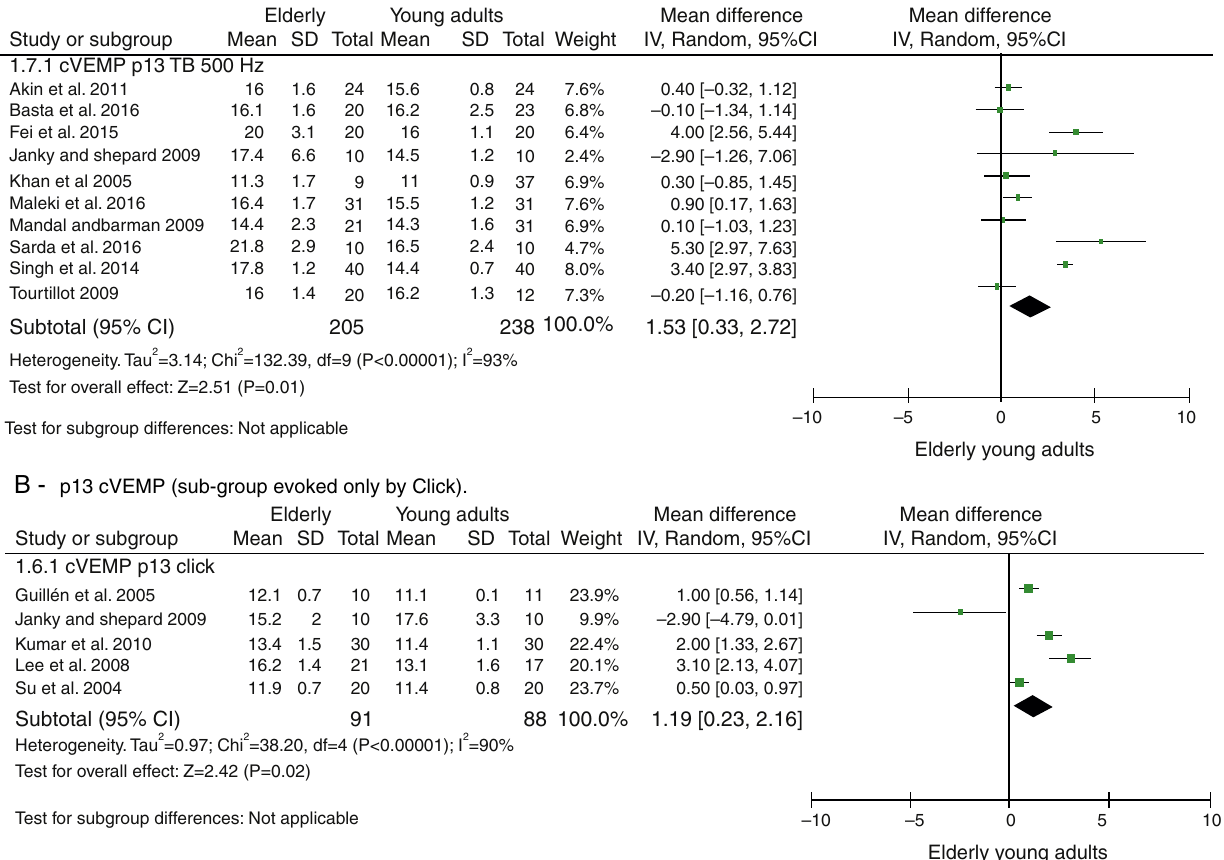
Meta-analysis: comparison of n13 cVEMP latencies, sub-groups evoked by 500 Hz Toneburst and only by Click. (A) p13 cVEMP (sub-group evoked only by 500 Hz Toneburst). (B) p13 cVEMP (sub-group evoked only by